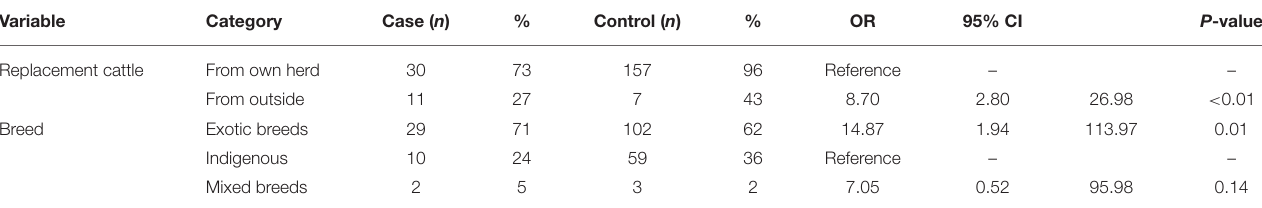
TABLE 2 | Multivariable analysis of the risk factors of Lumpy Skin Disease Outbreaks in Nakuru County. Variable Replacement